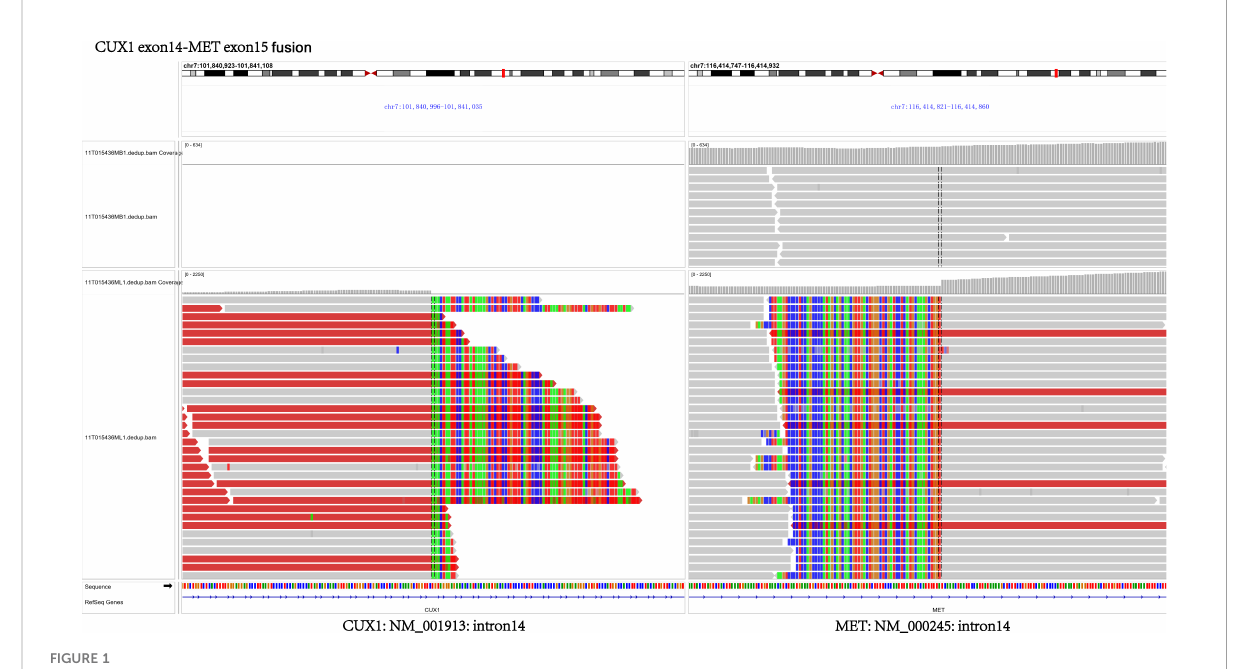
FIGURE 1 Next-generation sequencing detected MET